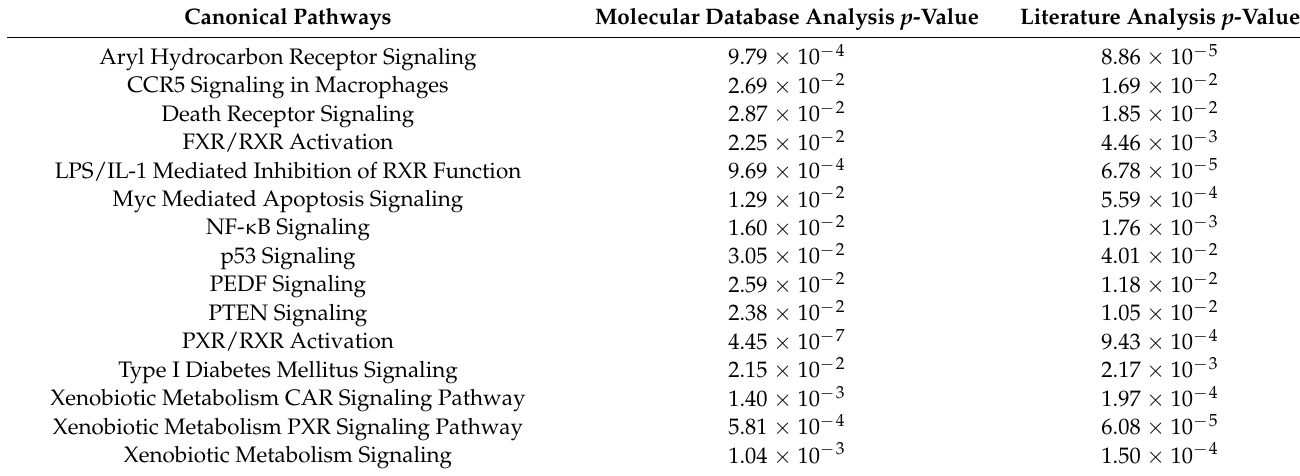
molecular databases and literature mining. Rows sorted by alphabetical order of canonical pathway.